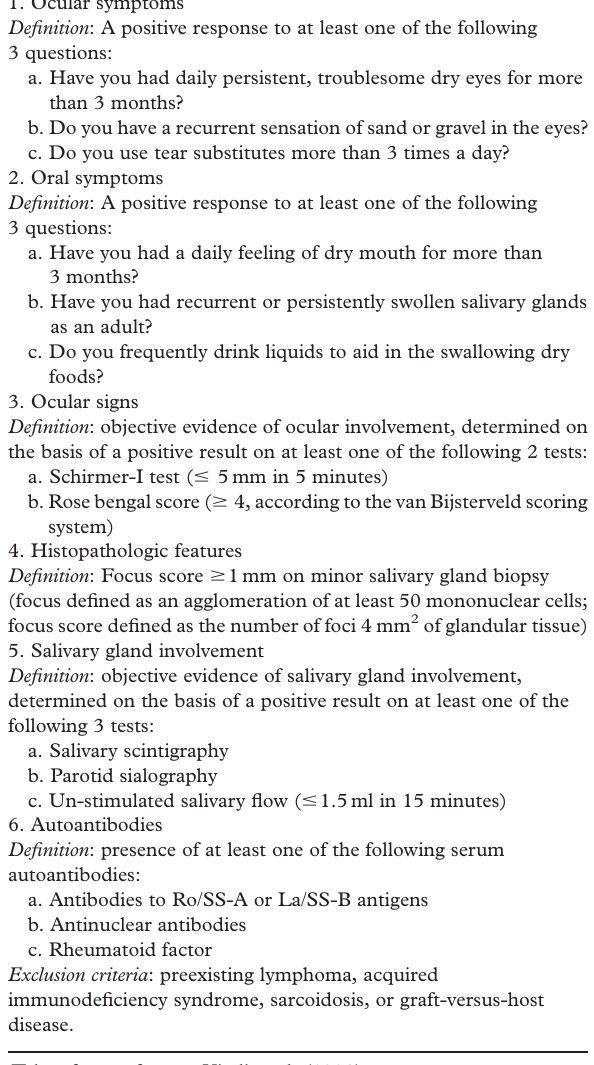
Table I. Revised diagnostic criteria for Sweet’s syndrome. Major Criteria 1. Abrupt onset of tender or painful erythematous plaques or nodules occasionally with vesicles, pustules, or bullae. 2. Predominantly neutrophilic infiltration in the dermis without leukocytoclastic vasculitis Minor Criteria